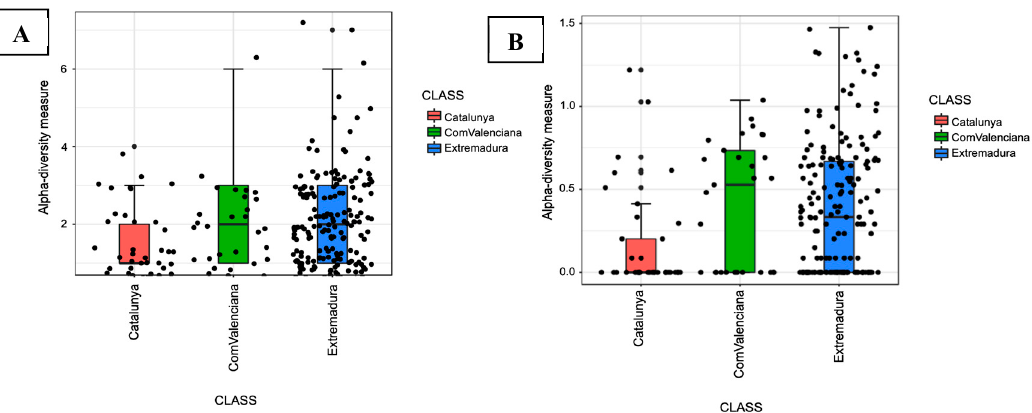
Figure 3. Boxplot showing alpha diversity measures of the Phytophthora diversity according to the factor region: Extremadura, Comunidad Valenciana (ComValenciana) and Cataluña (Catalonia). ( A) : Chao 1 estimator ( p value < 0.05). ( B) : Shannon index ( p value < 0.01). Table 3. Analysis of variance (ANOVA) tables for the alpha diversity of Phytophthora species detected in Extremadura dehesas during the surveys conducted in 2012 and